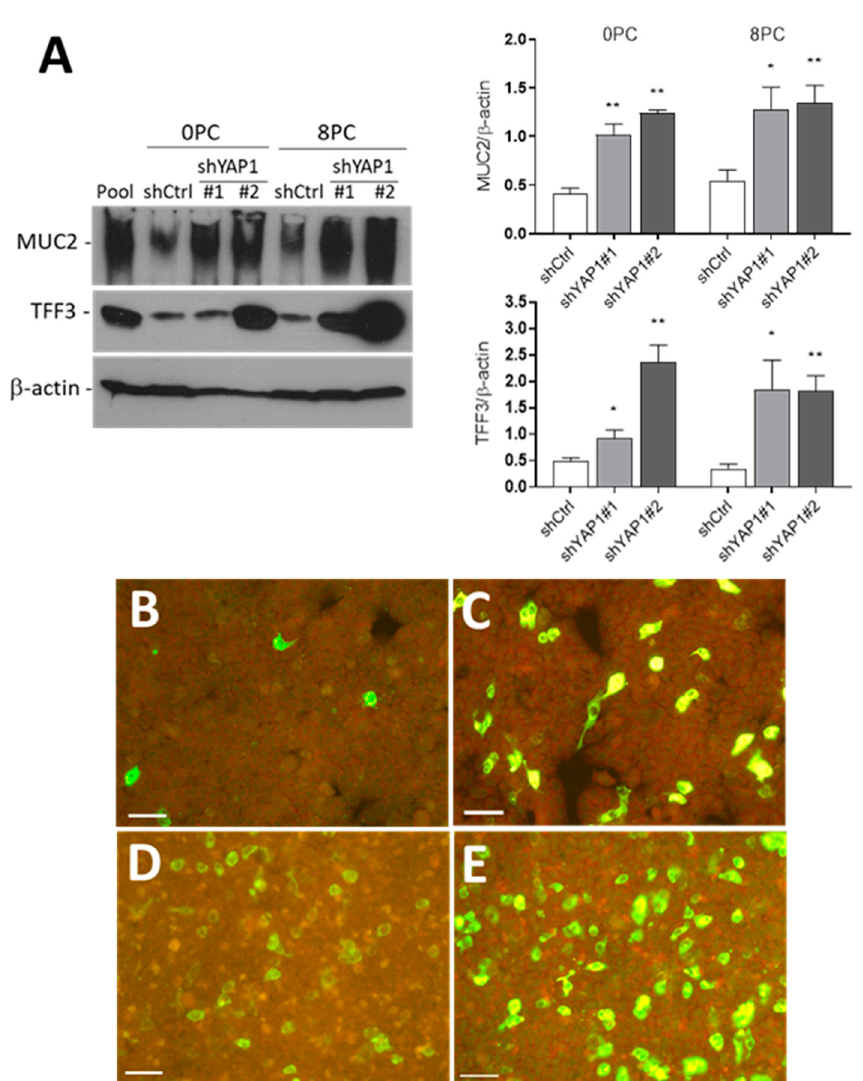
Figure 6. YAP1 knockdown stimulates goblet cell differentiation. ( A ) Representative Western blot analysis and data compilation from three separate experiments showing higher expression of MUC2 and TFF3 in shYAP1#1 and shYAP1#2 expressing cells relative to shCtrl cells at both Day 0 (0PC) and Day 8 (8PC) post-confluence. β -actin was used as a loading control. * p < 0.05, ** p < 0.005. ( B–E ) Indirect immunofluorescence analysis for the detection of MUC2 positive cells in shCtrl (B,D) and shYAP1#2 (C,E) at 0PC (B,C) and 8PC (C,E). Bar = 50 μ m.